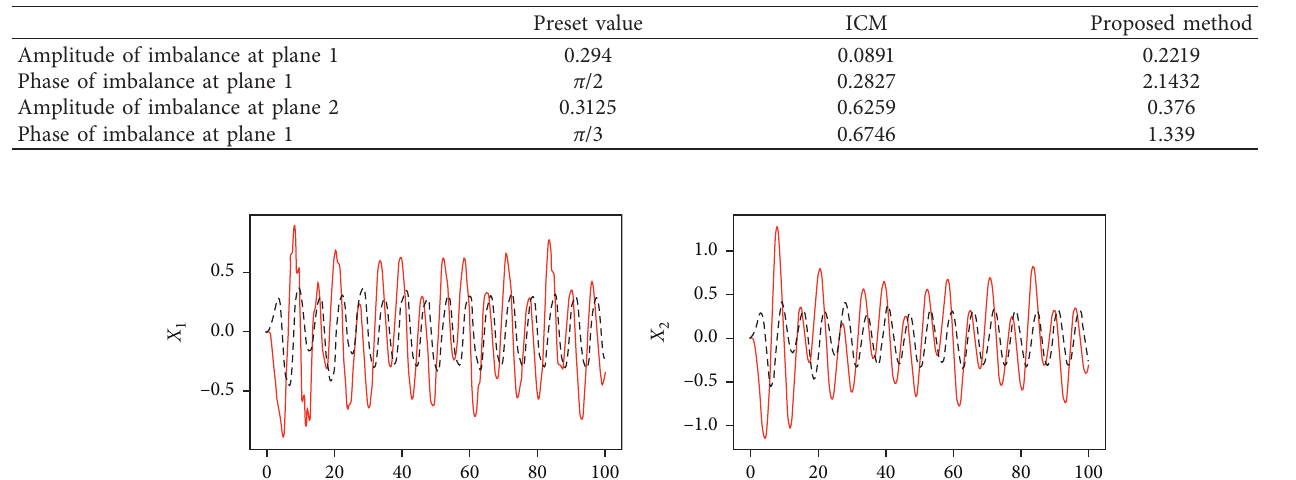
Table 1: The identification results of the unbalanced forces.